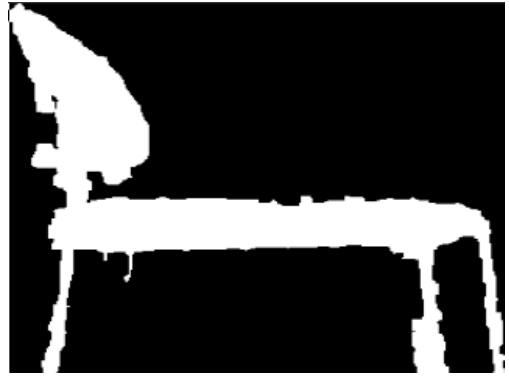
Figure 6. Biggest contour